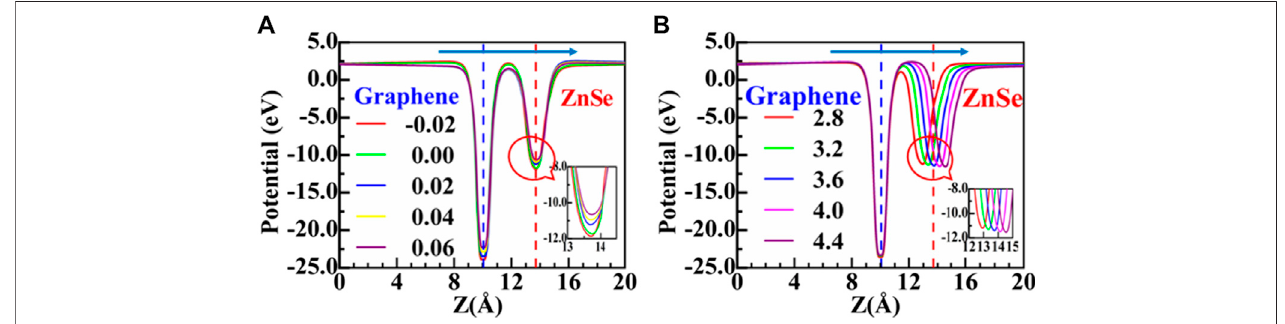
FIGURE 7 | (A) , (B) Average electrostatic potential along the z -direction for the heterostructure under different horizontal strains and vertical strains, respectively.